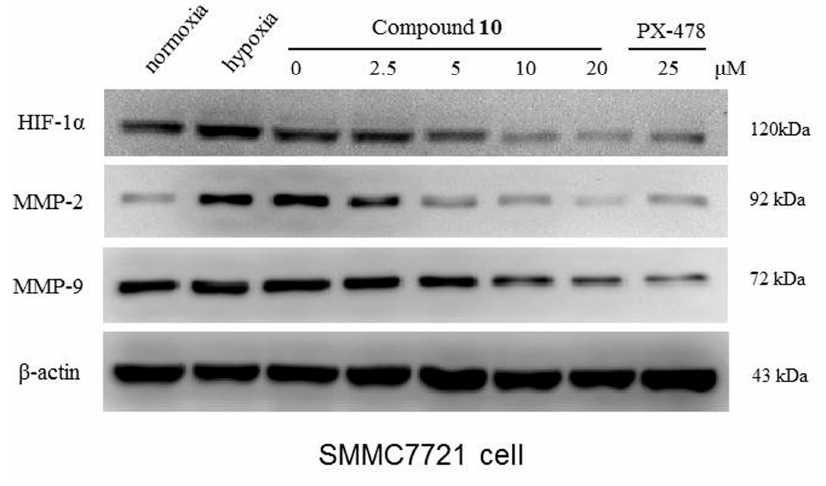
Figure 4. Effects of compound 10 on the expression level of HIF-1 α and its associated down- stream proteins: MMP-2 and MMP-9.